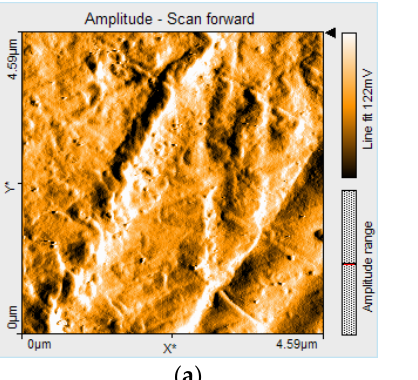
Figure 18. ( a ) Scanning amplitude (AFM) and ( b ) corresponding SEM image for a sample (DCT) with low nanoroughness values: Sa = 1.6 nm, Sp = 5.8 nm, Sv = − 12 nm.